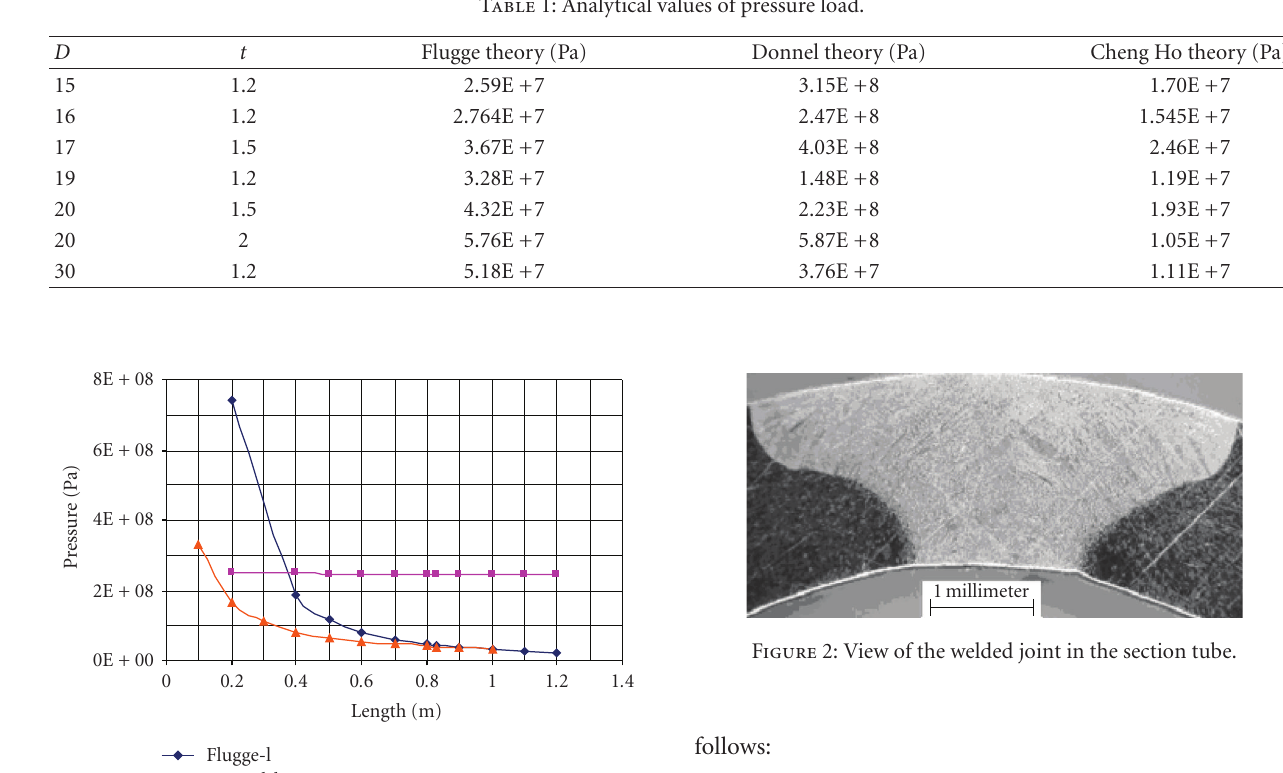
Table 1: Analytical values of pressure load.